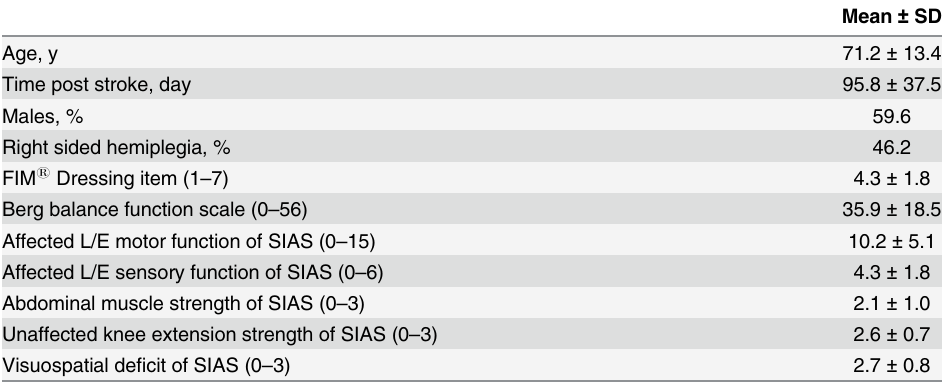
Table 1. Demographic, Stroke-related Characteristics of Study Subjects a